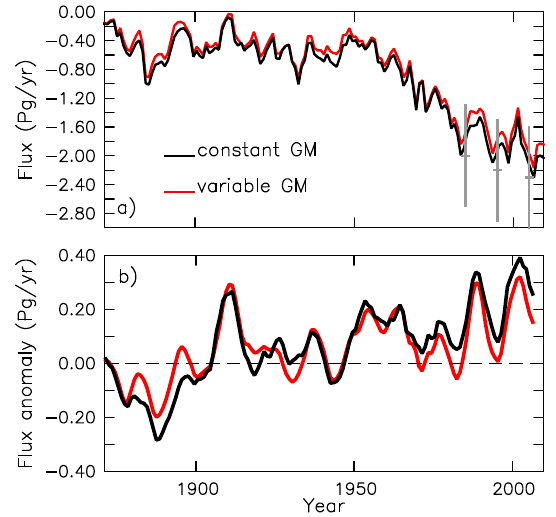
Figure 2. (a) Global net sea–air flux of CO 2 with time-evolving 20CR winds and (b) the surface flux anomaly due to the effect of time-evolving winds, computed as the difference between runs with time evolving and fixed winds. Fluxes are positive out of the ocean. The grey bars in (a) are observational estimates of the net flux (Ciais et al.,